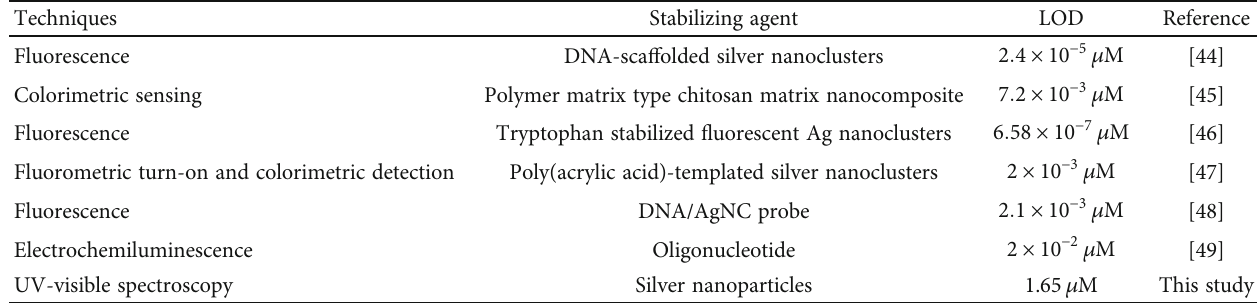
Table 2: Comparison method for the detection of Hg 2+ ions in tap